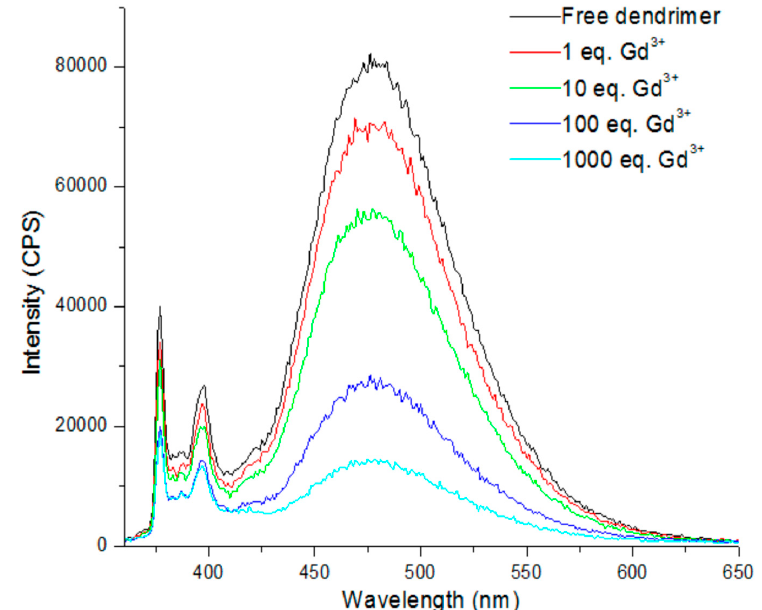
Figure 17. Titration of compound 4 with Gd 3+ in chloroform [127].